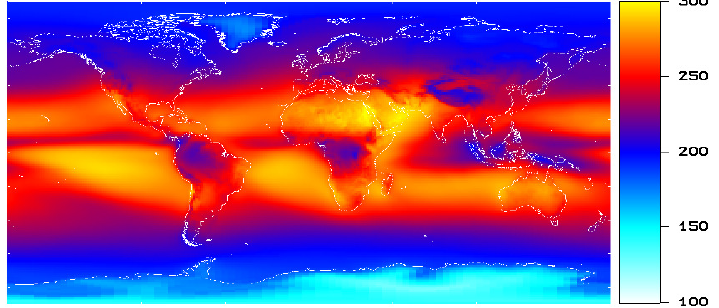
Figure 1. 2001–2017 mean all-sky CERES OLR. The scale is in W/m 2 .